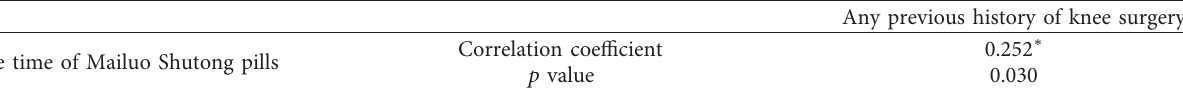
Table 13: Pearson correlations.